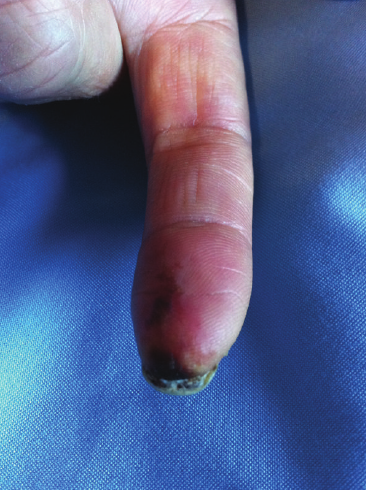
Figure 1: Left hand 2nd fingertip with vasculitic necrotising lesion.